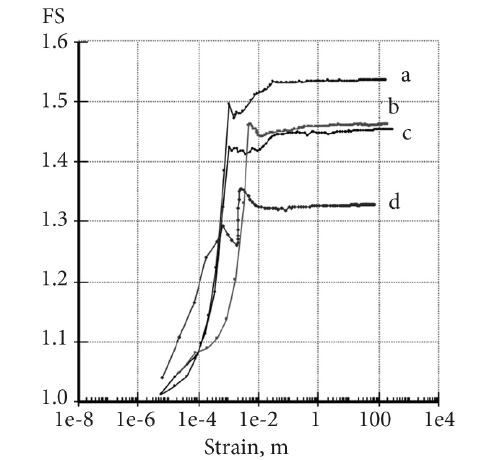
Figure 6. Slope Stability factors for varying ages of alder trees (a, 7 years old; b, 15 years old; c, without tree and d, 20 years old)